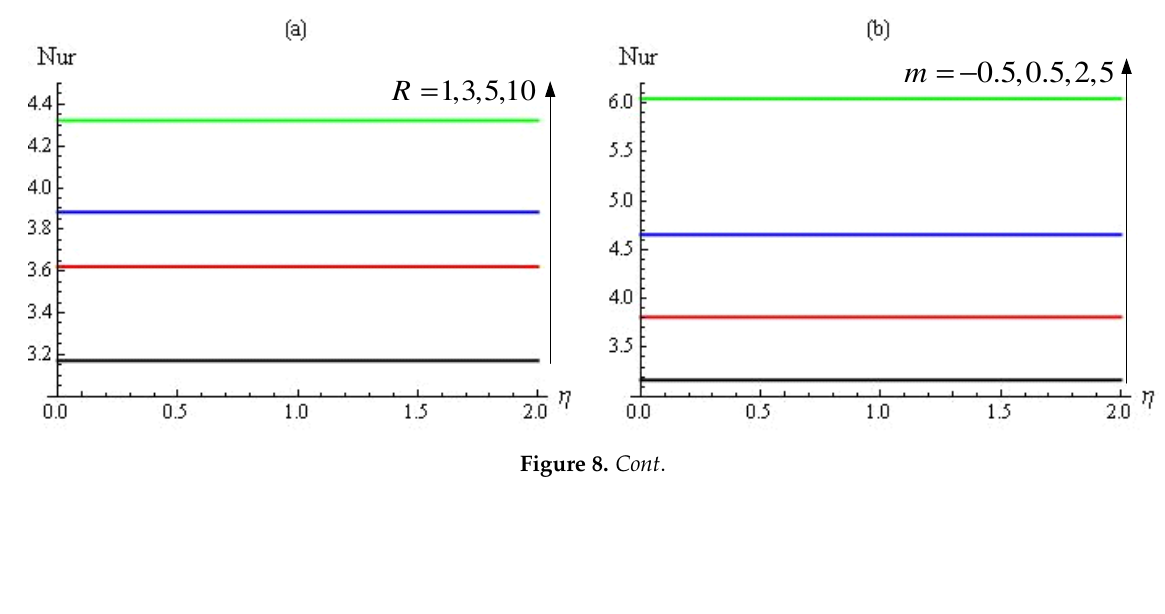
Figure 7. Impact of the Cu-nanoparticle volume fraction ( φ 2 ) on the temperature distributions.